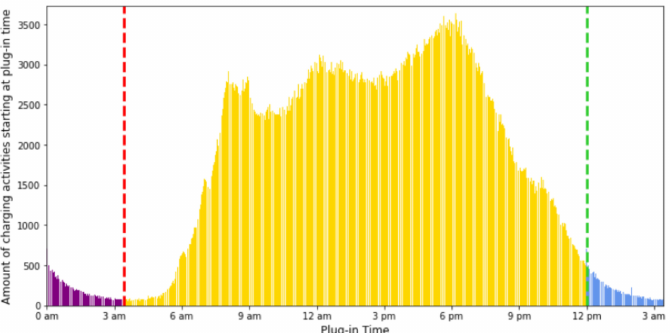
Figure 5. Distribution of the plug-in times (taking into account data